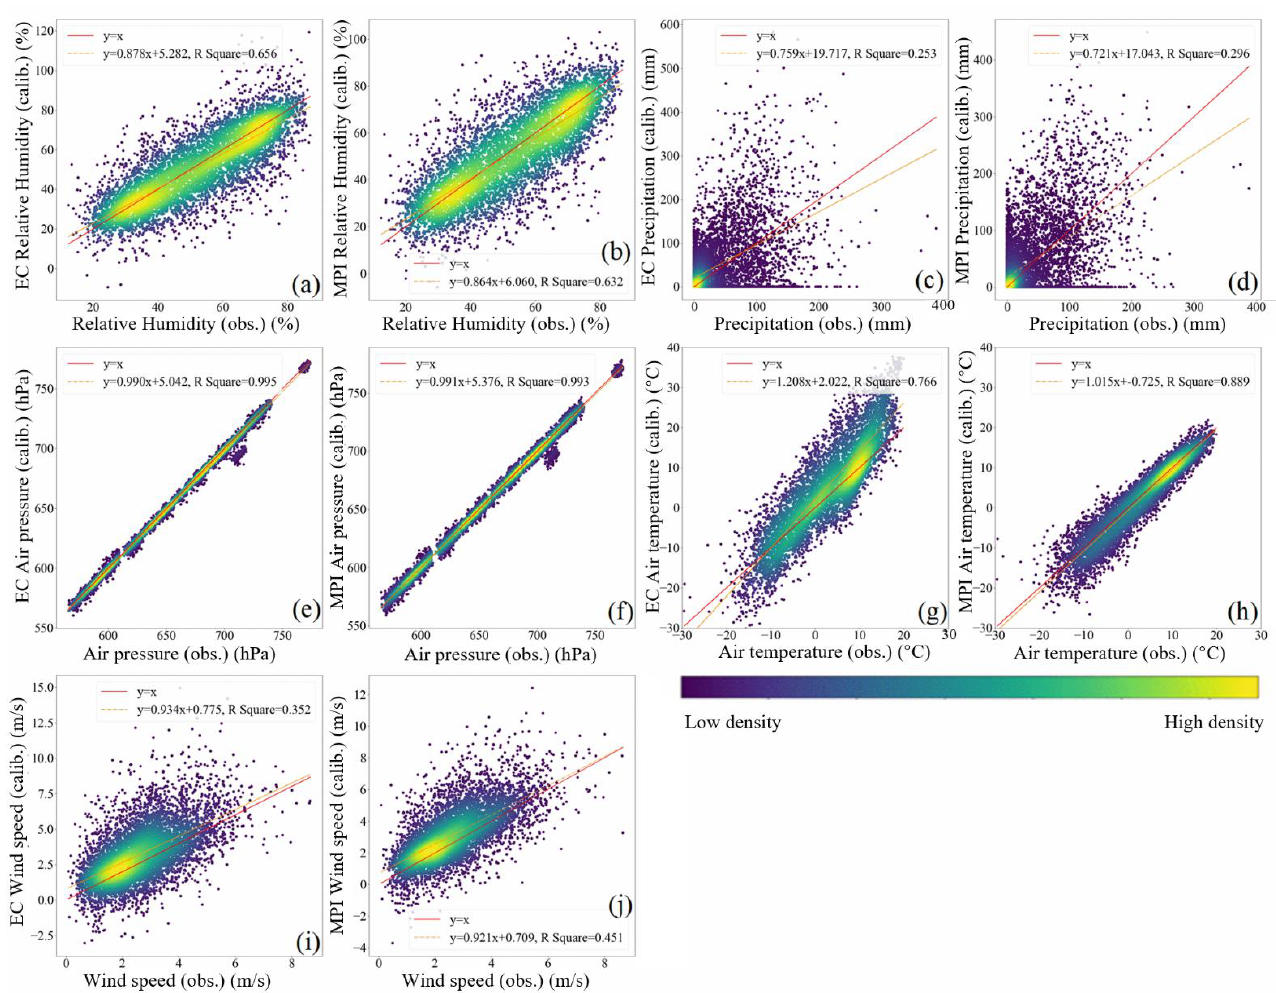
Figure 3. Calibrated results (the ordinates) and corresponding monthly observations (the abscissas) of five major meteorological variables at the 36 QTP sites in the first adjustment (1970–1984 as the control period and 1985–1999 as the projection period). The color ramp in the figure symbolizes the kernel density. The red solid lines represent a 1:1 line. The orange dashed lines represent the linear fitting curves of the samples in the subplots with the R square of each variable marked. Subplots ( a , c , e , g , i ) show the results from EC-Earth 3 (EC) GCM simulations; and ( b , d , f , h , j ) the MPI-ESM1.2-HR (MPI) GCM